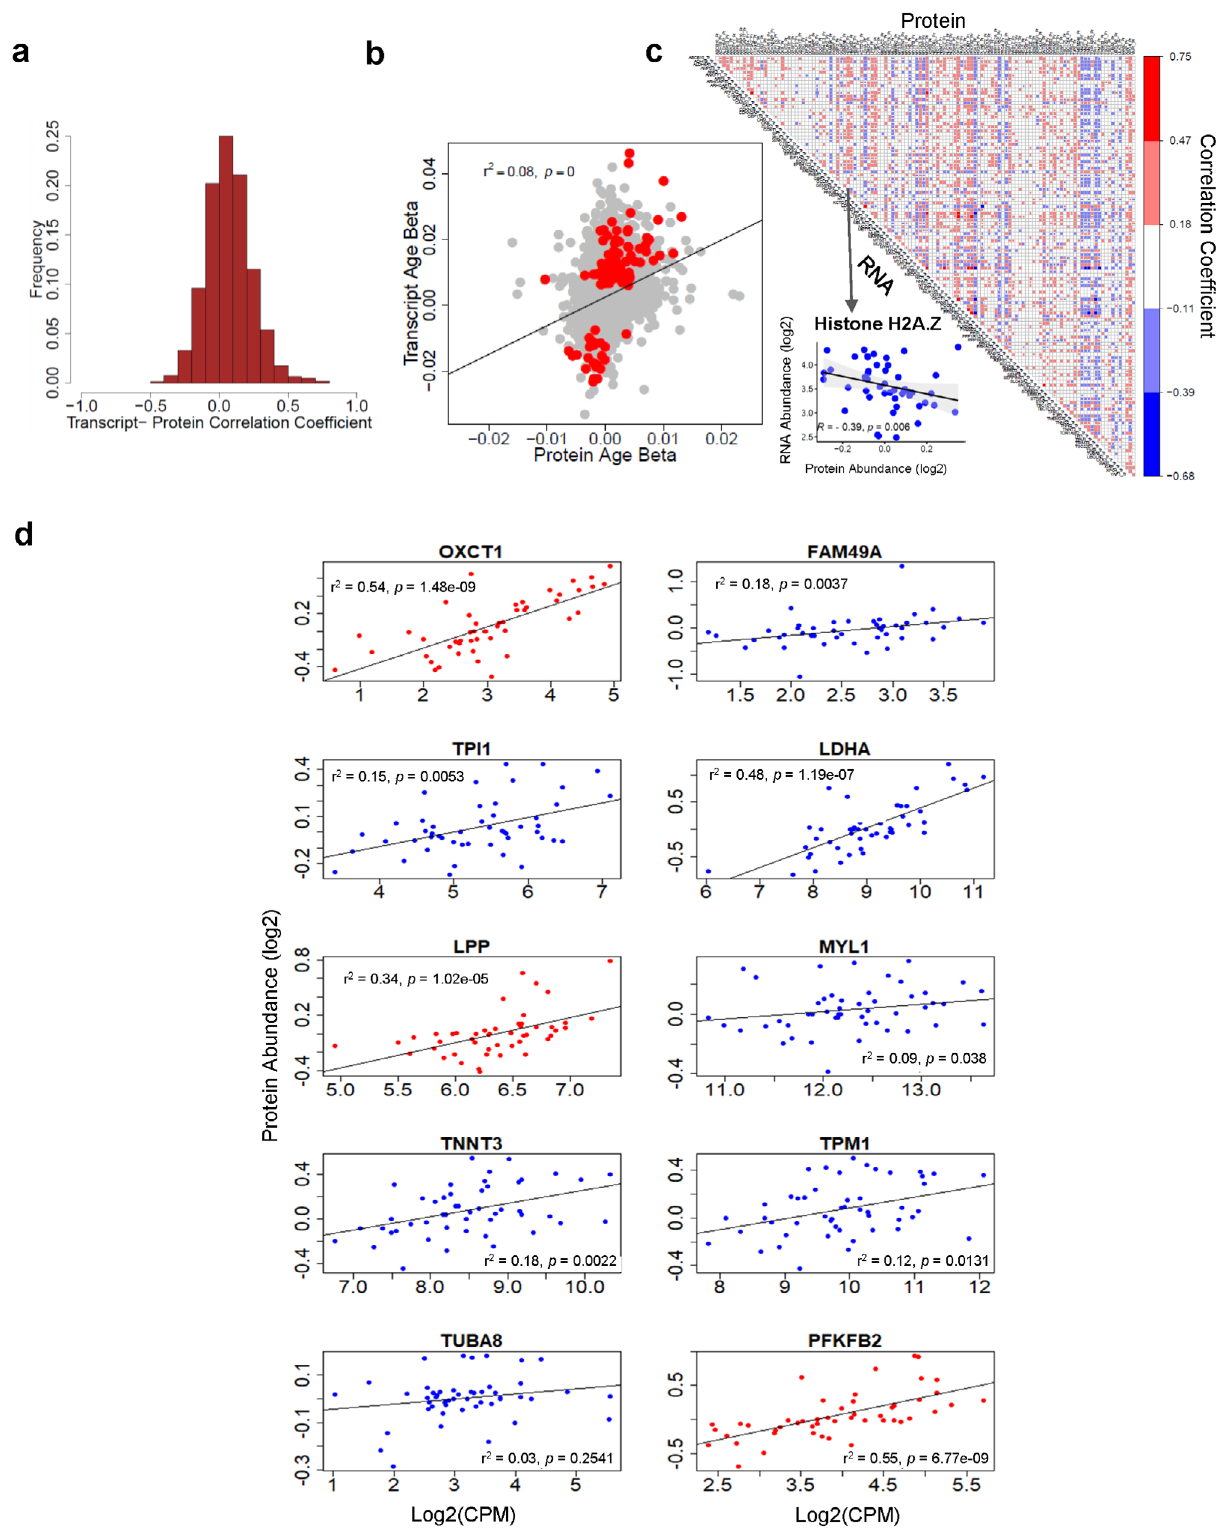
Fig. 5 Signi fi cant ( p < 0.05) downstream protein abundance and log2(CPM) correlations. a Distribution of 4281 protein – RNA correlation coef fi cients. b Scatterplot of the age β - coef fi cients for the protein – RNA matches limited to the 122 mRNAs signi fi cantly associated with age ( p -value from two-sided Wald test, unadjusted). c Heat map of 122 mRNAs signi fi cantly associated with age and their correlations with proteins. The mRNA with the strongest negative correlation (H2AZ) is shown in the inset ( p -value from two-sided Wald test, unadjusted). d Among all the RNAs in the four top 20 lists, ten RNAs were identi fi ed to have statistically signi fi cant correlations between relative protein abundance and age (red and blue points indicate mRNAs with positive and negative correlations, respectively). Of these ten RNAs, nine had statistically signi fi cant correlations between relative protein [log2(Protein Abundance)] and RNA abundance [log2(CPM)] ( p -values from two-sided Wald test,